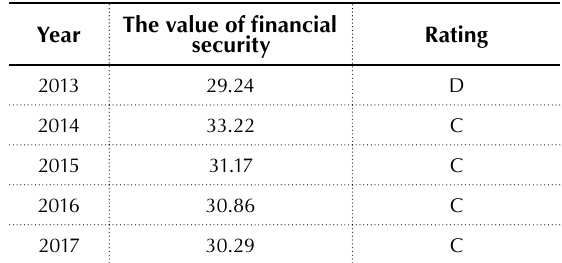
Table 6. Rating of financial security of Ukraine according to the Ukrainian methodology for assessing the financial and economic